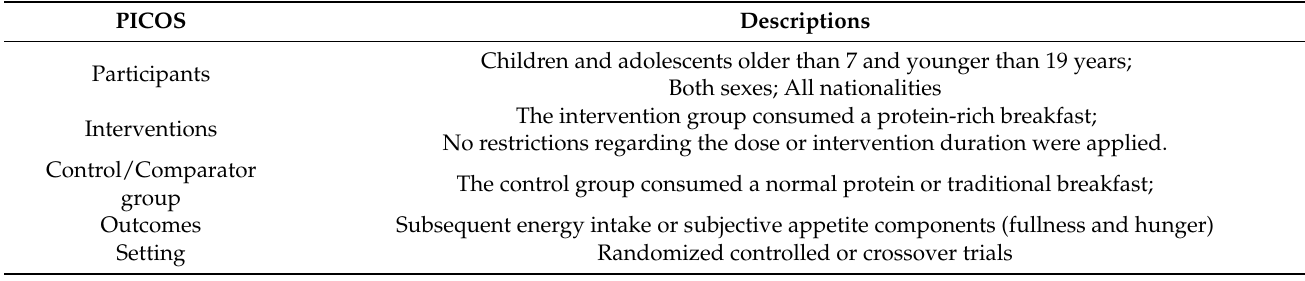
Table 1. Description of the PICOS (Participants, Interventions, Control, Outcomes) statement.